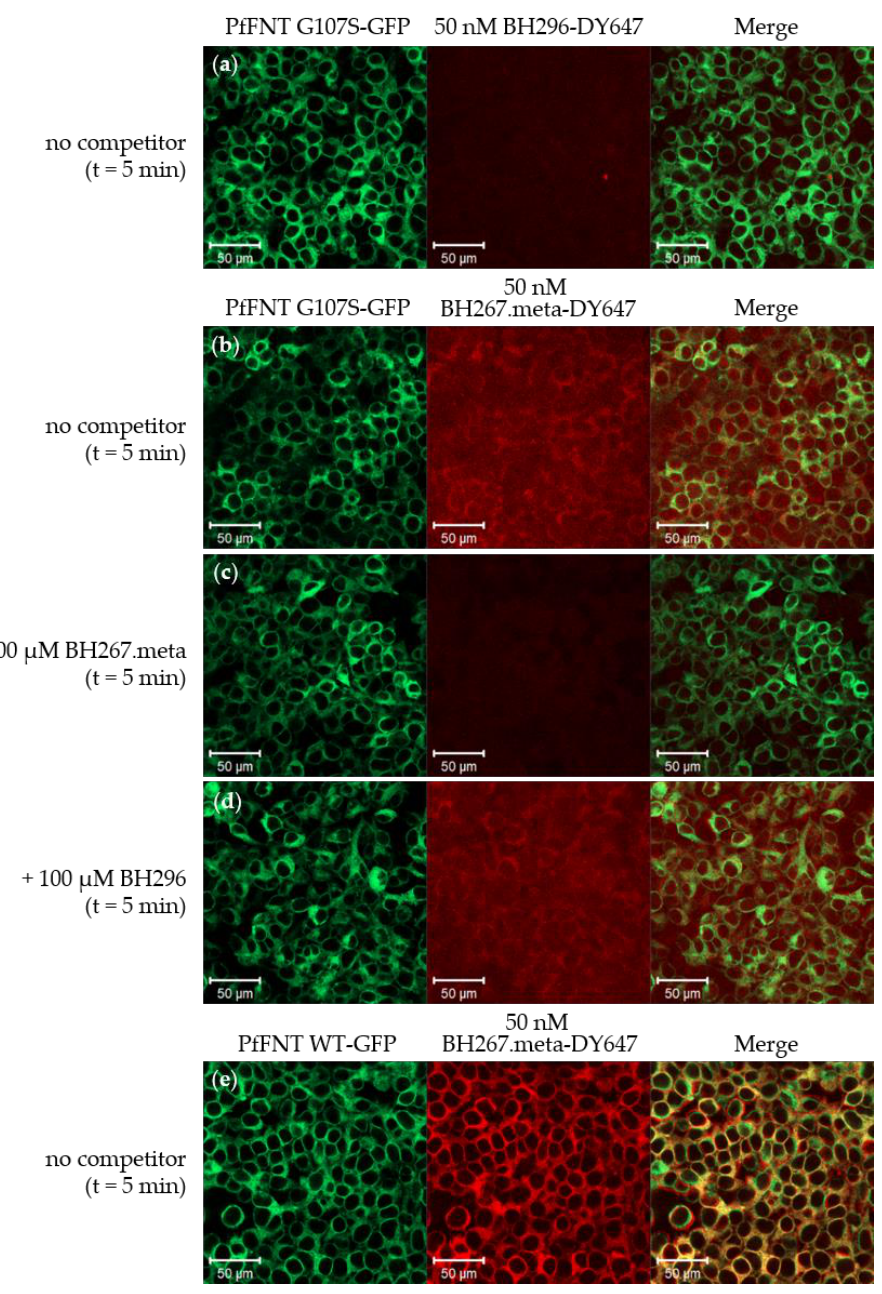
Figure 3. Live cell imaging of mutant PfFNT G107S-GFP stably expressed in HEK293 cells and binding of labeled ligands BH296-DY647 and BH267.meta-DY647. BH267.meta-DY647 ( b ), but not BH296-DY647 ( a ) co-localizes with the membrane-bound G107S mutant of PfFNT-GFP, and competition with 100 µM BH267.meta prevents membrane localization ( c ). Based on fluorescence intensity levels, the interaction appears to be weaker than for the wild type PfFNT-GFP to BH296-DY647 (see Figure 1b,c). ( d ) The interaction cannot compete with BH296. ( e ) BH267.meta-DY647 localizes with PfFNT wildtype. Incomplete overlap of both channels in E does not represent altered localization but can be attributed to an offset between both channels and thus is irrelevant for the drawn conclusion of the experiment.